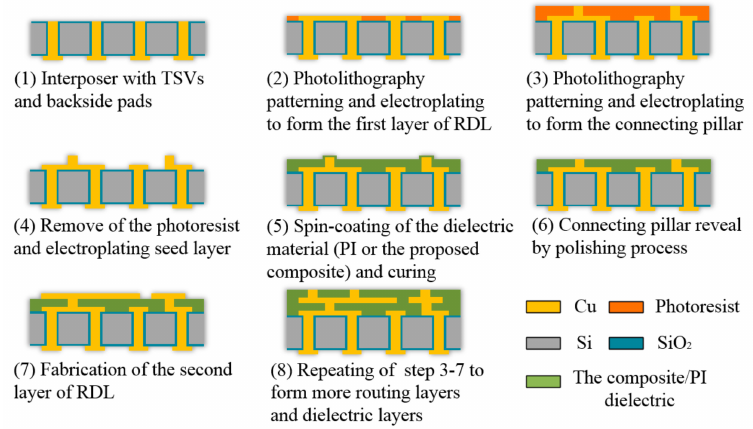
Figure 8. The fabrication process of the interposer redistribution layer (RDL).